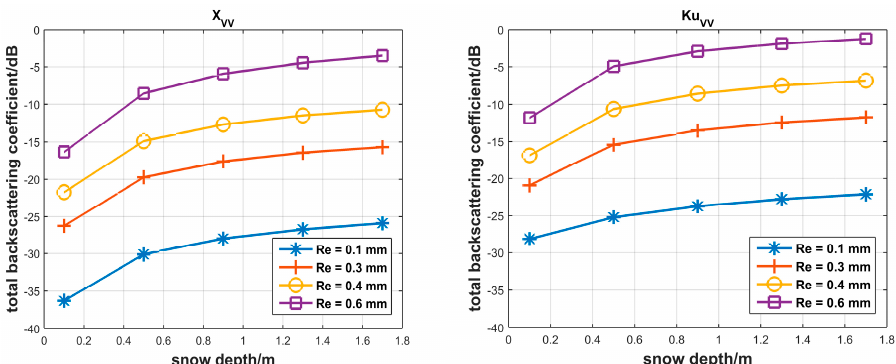
Figure 2. Total backscattering coefficient from dry snow at X ( left ) and Ku ( right ) bands with VV polarization and incidence angle of 40° against increase in snow depth. The values of 0.1 mm, 0.3 mm, 0.4 mm and 0.6 mm were applied for the optical grain size R e . The b parameter was 1.2.